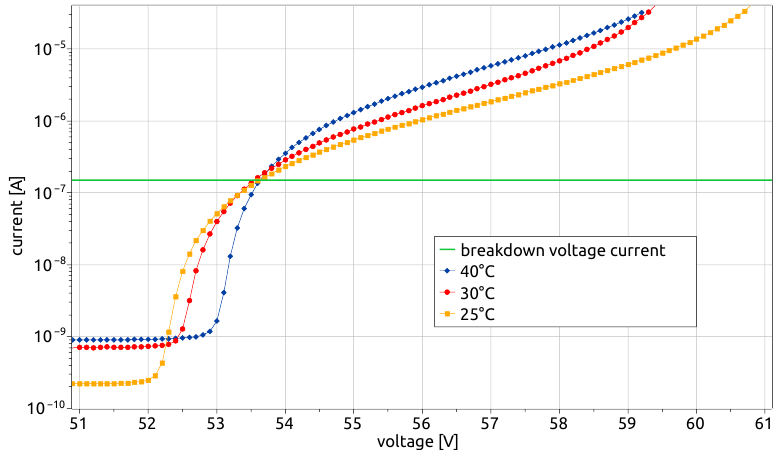
Figure 25. Current—voltage characteristics of SiMP under different